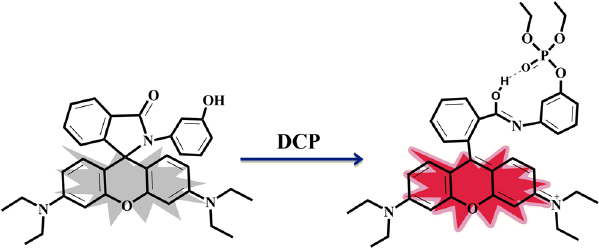
Figure 1. “Turn-on” fluorescence sensing mechanism of ARC upon addition of DCP .